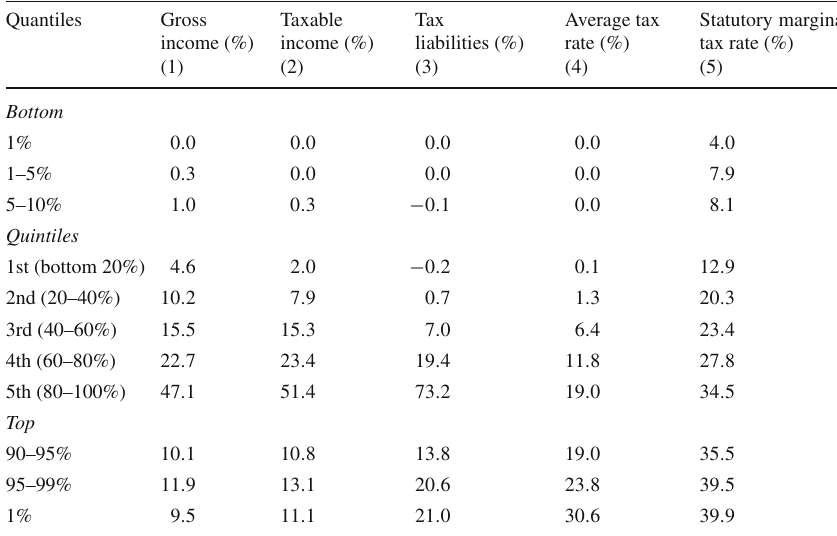
Table 7 Distribution of individual tax liabilities and tax rates